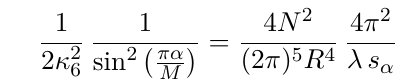
JHEP10(2021)161